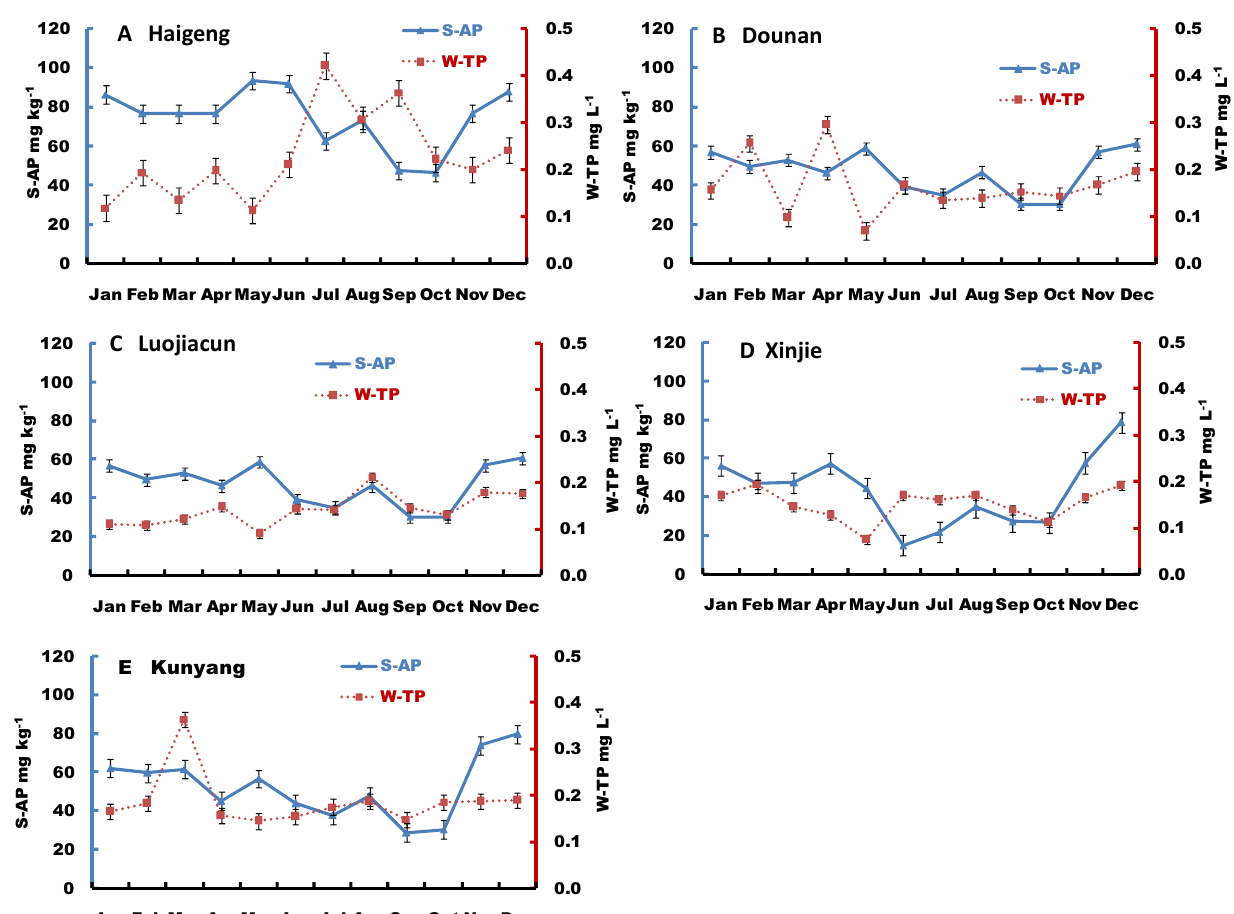
Figure 4. ( A – E ) Sediment available-P (S-AP) (0–5 cm) and water total phosphorus (W-TP) at the sediment–water interface of Dianchi Lake.